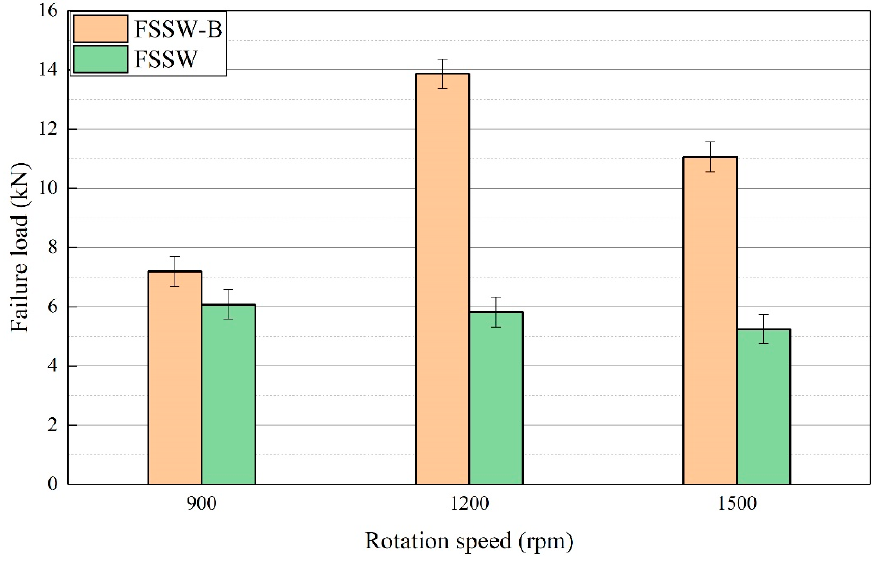
Figure 9. Comparison of lap shear fracture load of FSSW-B and FSSW joint at the same tool rotation speeds.